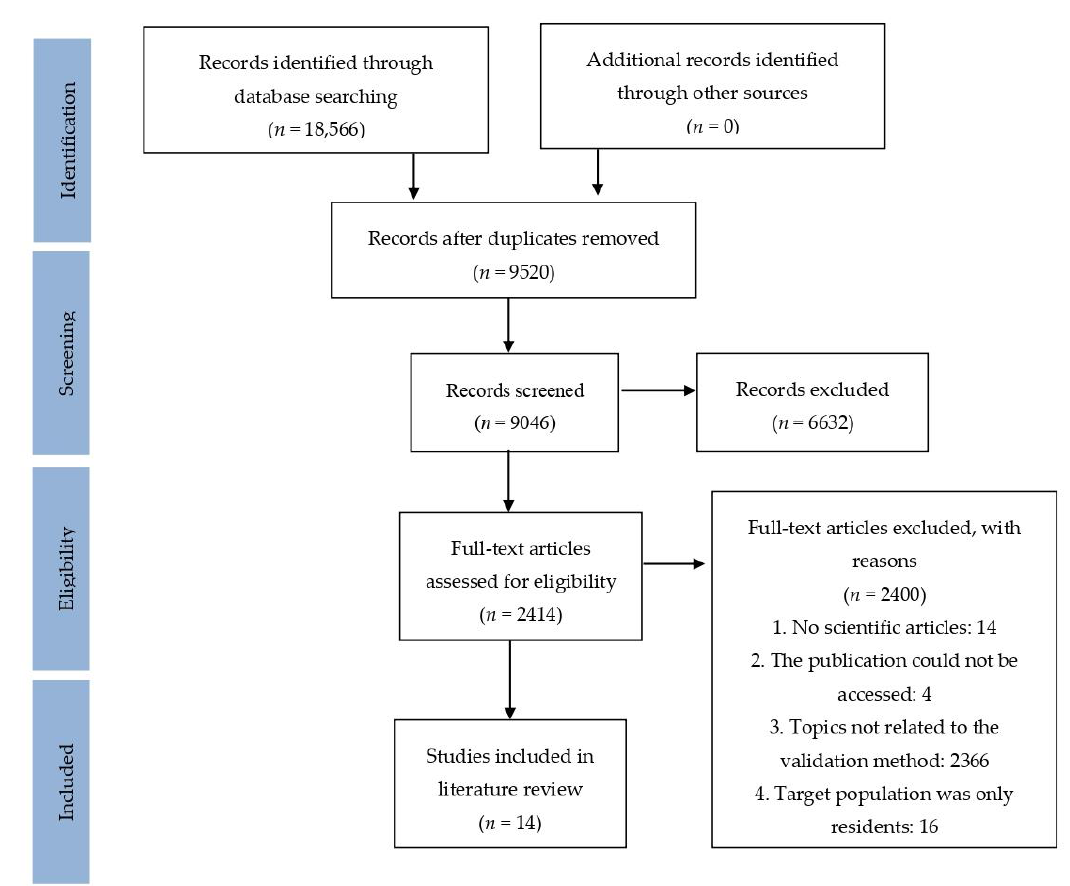
Figure 1. Literature analysis process.